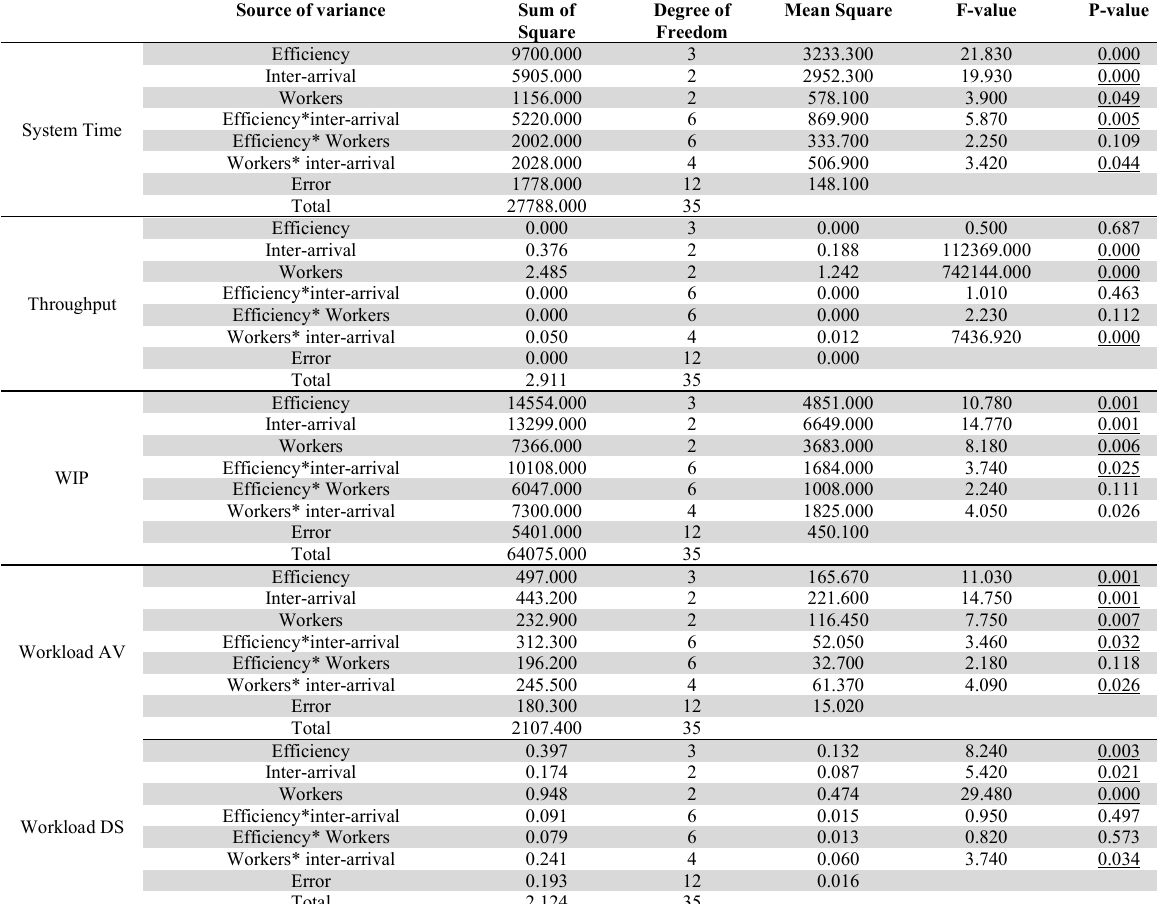
ANOVA Results - Manufacturing System